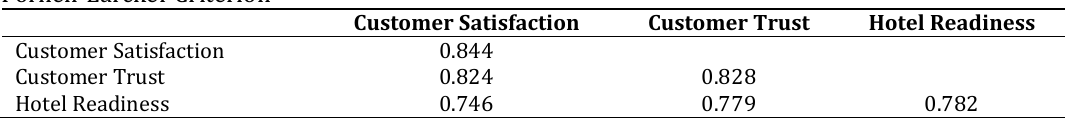
Table 5: Discriminant validity for local chain hotel Fornell-Larcker Criterion